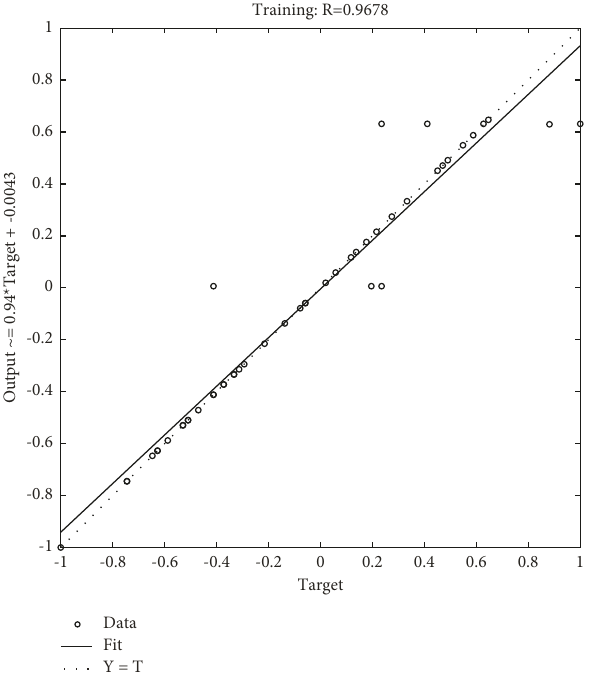
Figure 9: Accuracy of neural network training for scenario (3).